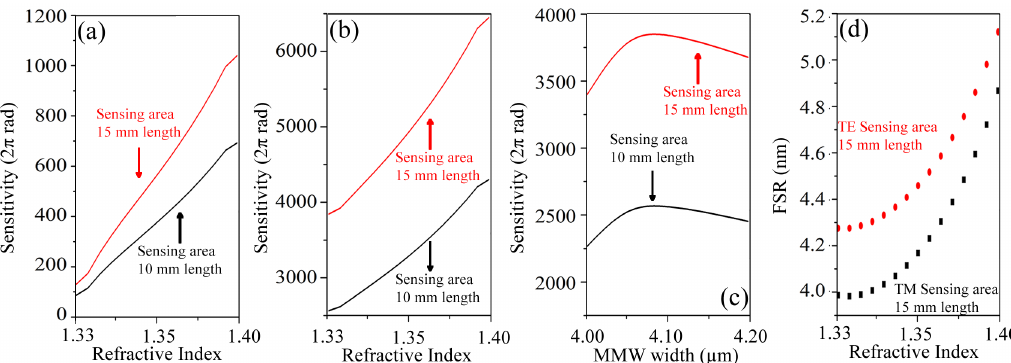
Figure 6. Bulk sensitivities for 10mm and 15mm length in the sensing area. ( a ) Simulated sensitivity for fabricated devices, as function of refractive index variation on the sensing area, for TE propagation mode. ( b , c ) Simulated sensitivity for optimized trimodal component, as function of refractive index variation on the sensing area, and variation of the width dimensions in the trimodal region, respectively. ( d ) Free Spectral Range for the optimized trimodal